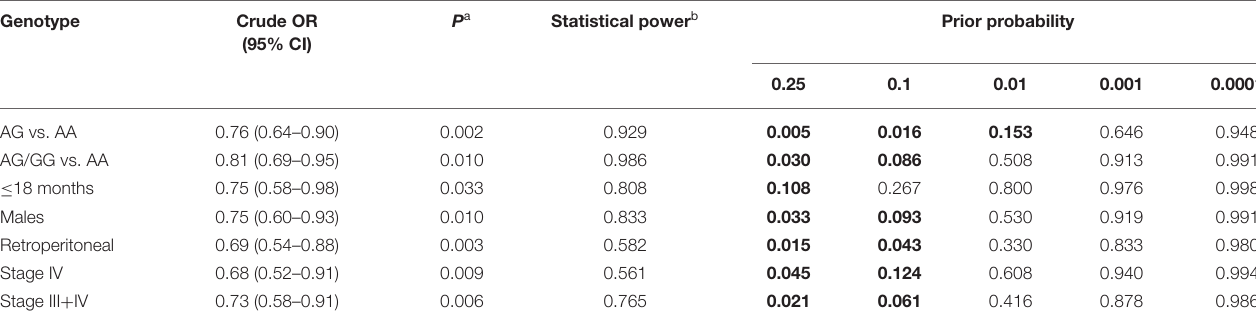
TABLE 3 | False-positive report probability analysis for significant findings for the association between YTHDF2 rs3738067 A > G polymorphism and neuroblastoma susceptibility. P a Statistical power b Prior probability Genotype Crude OR (95% CI)